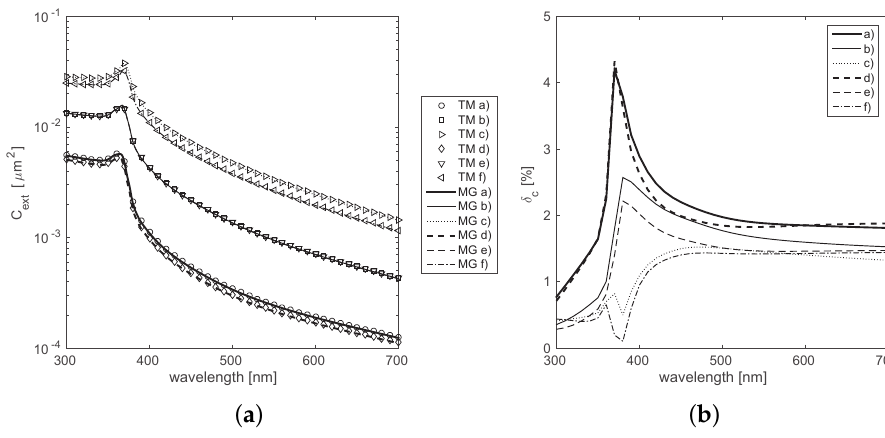
Figure 5. Extinction cross sections ( a ) and relative deviations of extinction cross sections ( b ) of mesocrystalline particles computed with the Maxwell-Garnet approximation and the T-matrix method. Letters (a–f) in the legends refer to the structure geometries of Table 1 and Figure